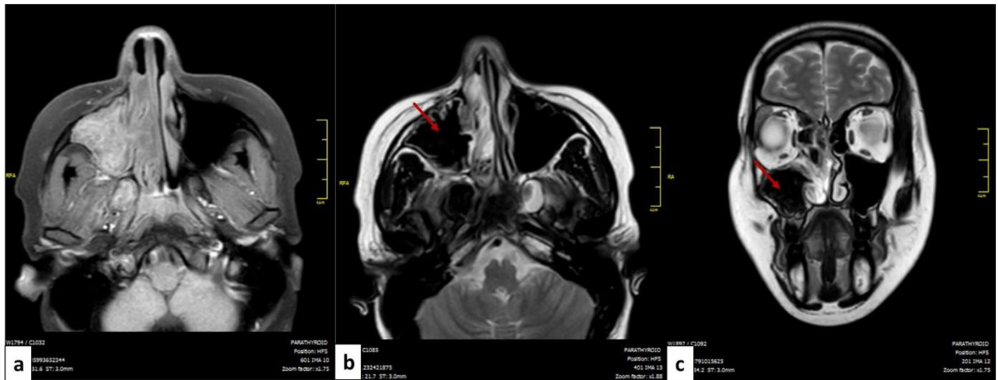
Figure 2. MRI of the facial mass of a patient with allergic fungal rhinosinusitis: axial cut ( a , b ) and coronal cut ( c ). The filling of the left maxillary sinus is presented in isosignal T1 ( a ) and in hyposignal T2 or signal void (red arrow) ( b , c ).